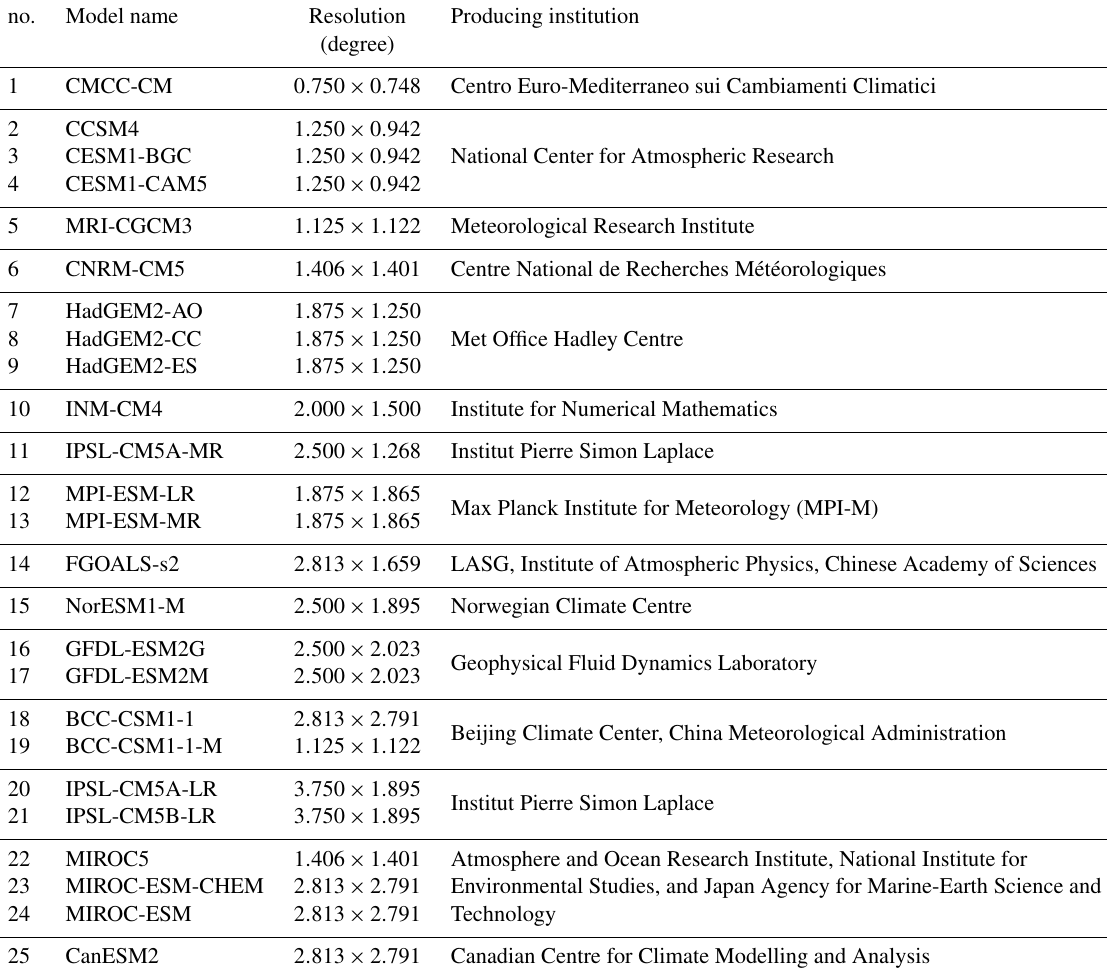
Table A1. List of the selected GCMs for the impact assessment under the RCP4.5 and 8.5 scenarios.